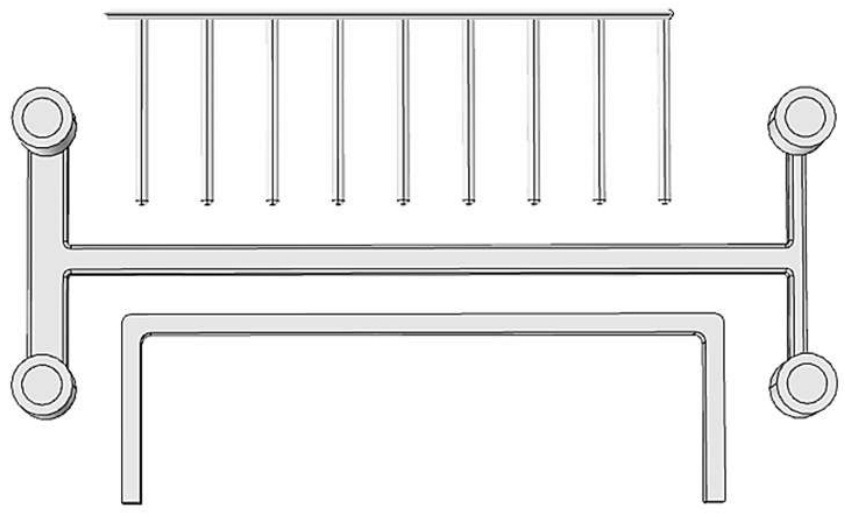
Figure 2. Graphical representation of the placement of the electrodes along the main channel. Using crocodile clamps connected to an Aim-TTi QPX600DP Bench Power Supply (600 W, 2 Output, 0 → 80 V, 0 → 50 A), the parallel electrode was set at ground Using Ø 1 mm diameter microfluidic tubes, the systems’ inlets were connected to two syringes: one filled with 3 mL bacterial suspension (7.5 × 10 8 CFU/mL); and the other one filled with 3 mL nutrient broth (MBH, Bio-Rad, Marnes-la-Coquette, France), to ensure a proper growth medium for the bacterial biofilms. 2.2. Biofilm Cultivation, Formation, and Growth Choosing a relevant bacterial strain for this study was a challenging step. One of the most common bacteria involved in biofilm-related infections is the Gram - positive Staph- ylococcus aureus ATCC 25923. The bacterial strain was cultivated on 5% sheep-blood agar (bioMerieux, 107 Marcyl’ Étoile, France) plates and incubated for 24 h at 37 °C. By picking up colonies from the agar plates and mixing them in 5 mL saline solution, 2.5 McF bacte- rial suspensions were prepared. The obtained solutions and suspensions were drawn in syringes and pushed through the microfluidic systems using a SP230iwZ Syringe Pump (WPI), at a flow rate of 0.3 mL/min, at room temperature (Figure 3). Once the main channel started filling up with fluid, the Power Supply Bench was turned on, and several potential values, varying be- tween 10 and 60 V were applied to the electrodes. This potential was applied until the flow of fluids was stopped within the microfluidic devices. The next step consisted of cul- tivating the microfluidic devices at 37 °C for 120 h, followed by an inactivation step using UV light. Previous to the analysis, the devices were cut along the main channel using a Robotec laser cutting machine, and for the scanning electron microscopy (SEM) analysis, the samples were washed with 3 mL absolute alcohol solution and air dried.